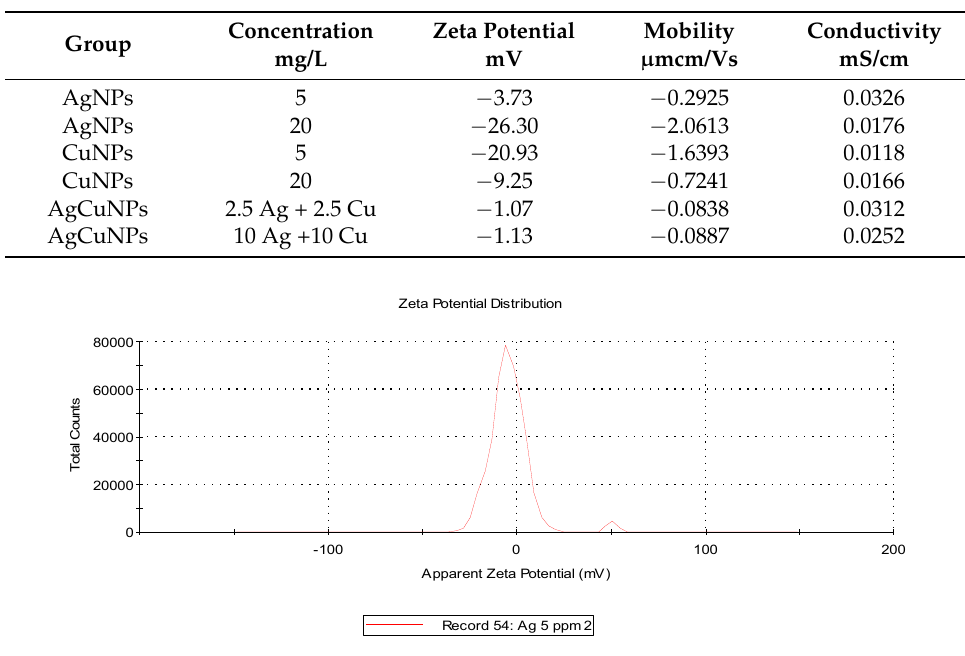
Table 1. Physicochemical properties of silver (AgNPs), copper (CuNPs), and synthetized silver–copper nanoparticles (AgCuNPs).